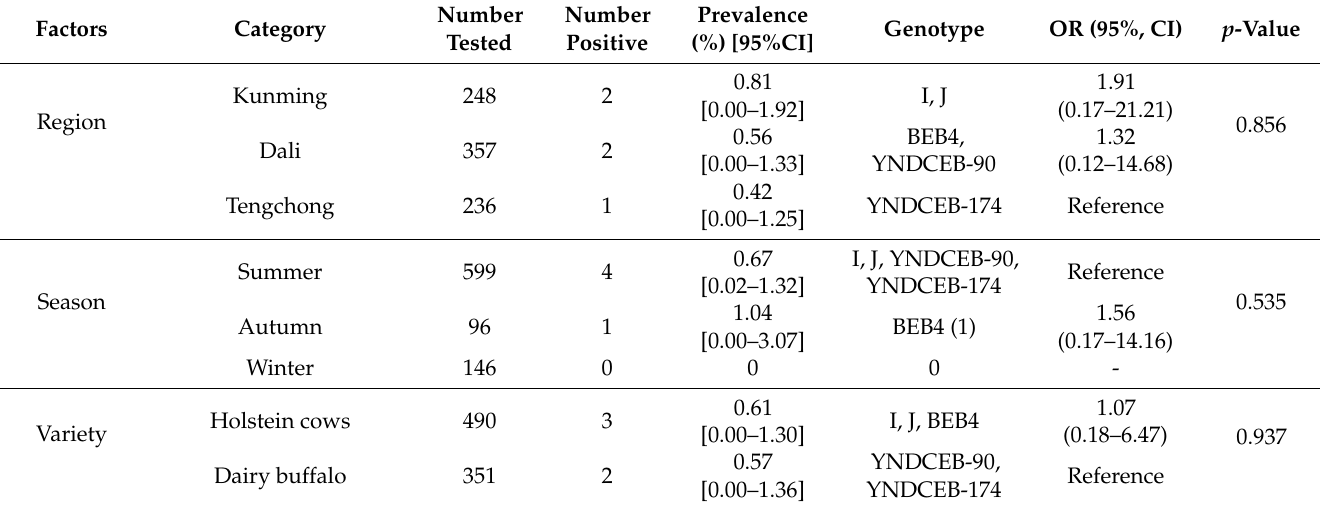
Table 1. The infection of E. bieneusi in some dairy cattle in Yunnan